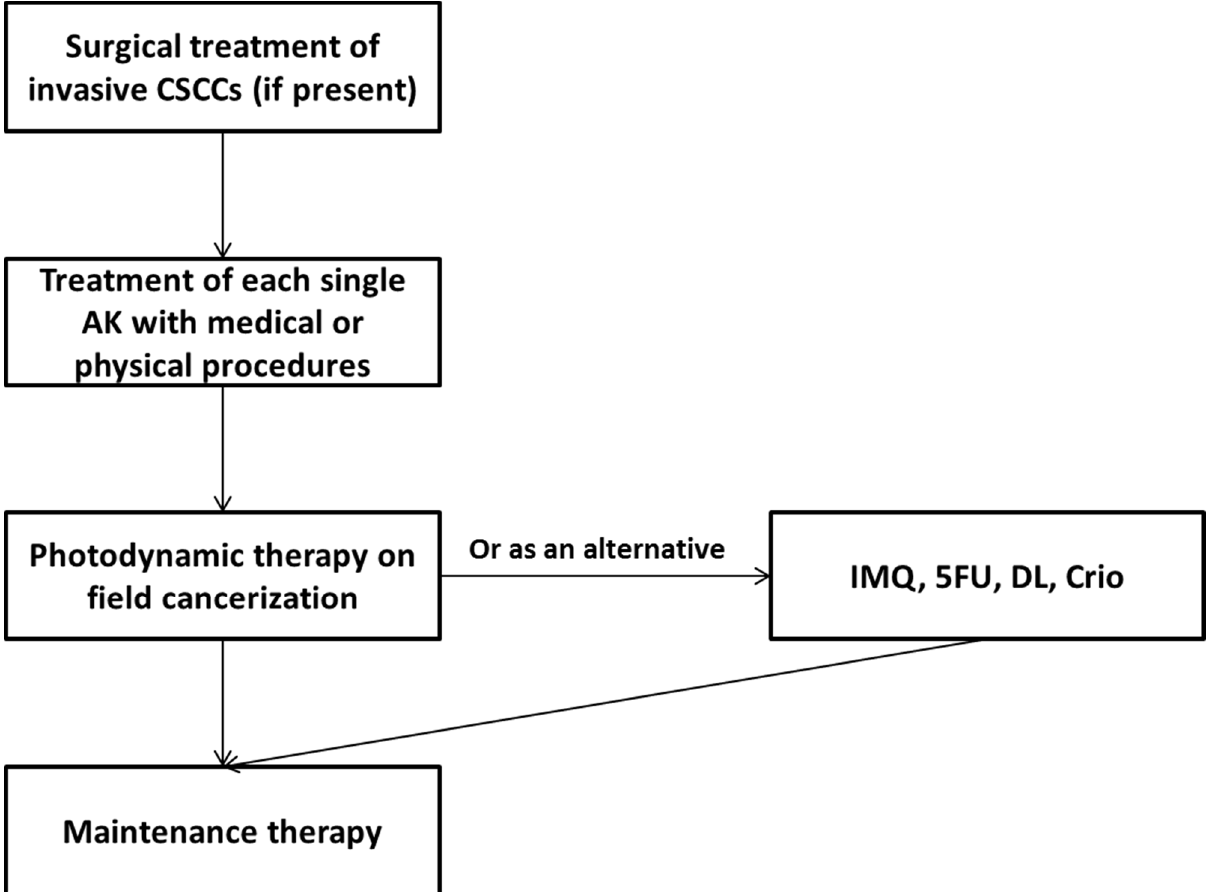
Figure 1. Algorithm of management of patients with actinic keratosis. Maintenance therapy may include agents such as nicotinamide, polypodium, and photoliasis. Abbreviations: 5FU: 5-fluororacil; AK: actinic keratosis; Crio: cryotherapy; CSCC: cutaneous squamous cell carcinoma; DL: day light photodynamic therapy; IMQ: imiquimod.